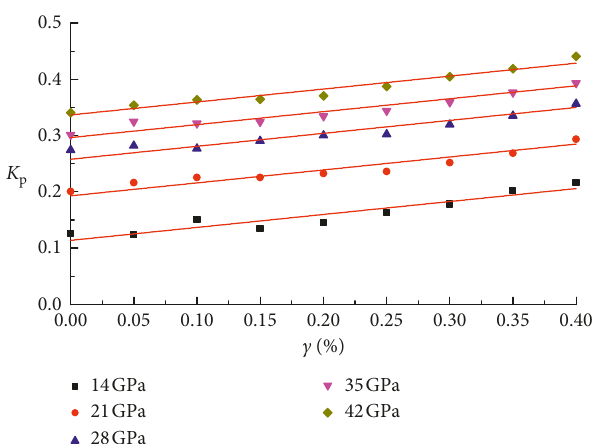
Figure 8: Energy dissipation ratio versus end-face nonparallelism.